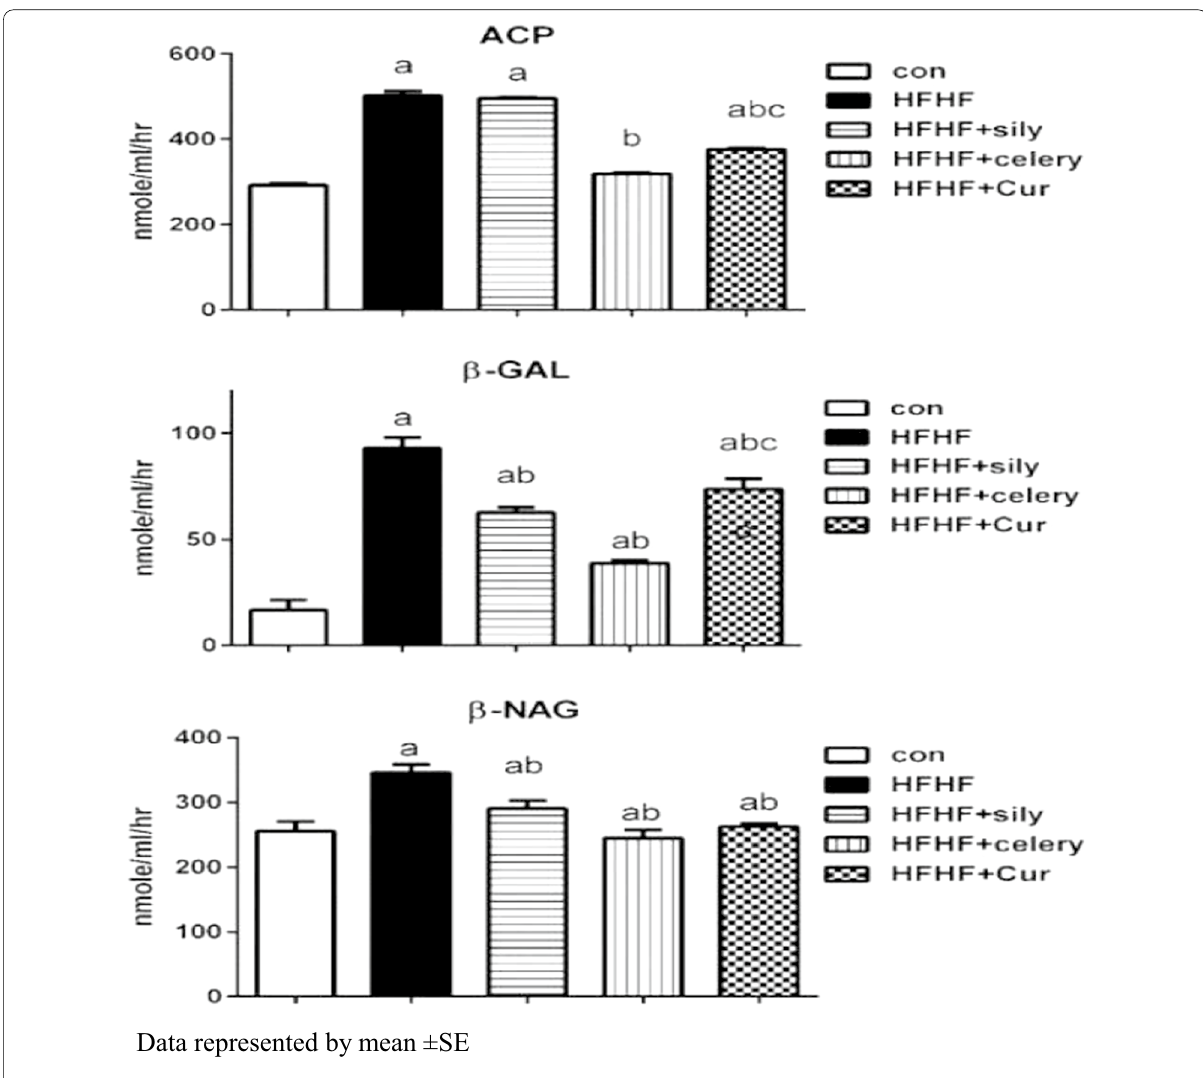
Fig. 1 The effect of HFHF alone or in combination with celery, curcumin, and silymarin on three marker lysosomal enzymatic activities (ACP, acid phosphatase; β-GAL, β-galactosidase; and β-NAG, N -acetyl-B-glucosaminidase) in rat liver lysosomes. Data represented by mean difference from control at P < 0.05. b p significant difference from HFHF at P < 0.05. c p significant difference between HFHF groups at P <